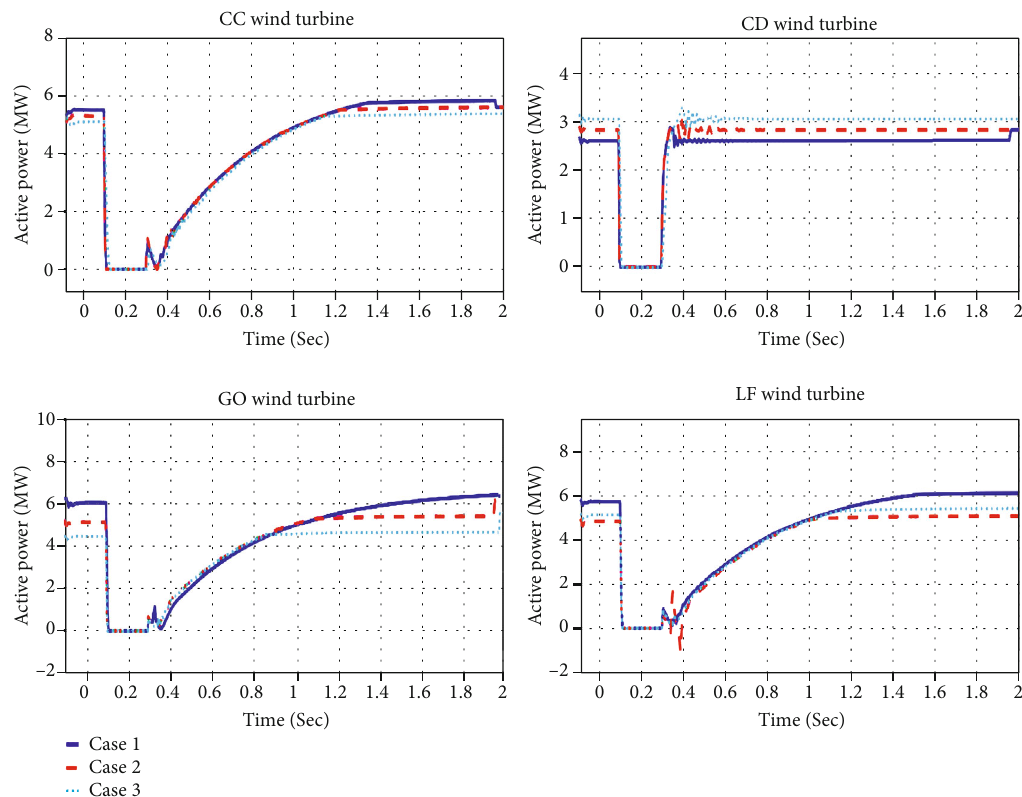
Figure 12: Active power from wind turbine modules according to the four dispatch strategies. This fi gure is reproduced from Shezan et al.